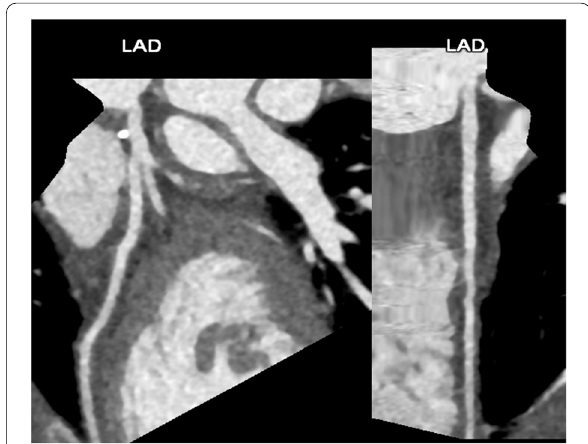
Fig. 4 (2D postprocessing): automatically 2D recontructions of the three main coronary arteries are generated, here the LAD in curved (left) and straight (right) MIP projections; this allows a rapid assessment at first sight and facilitates the review of finding by the referring physicians